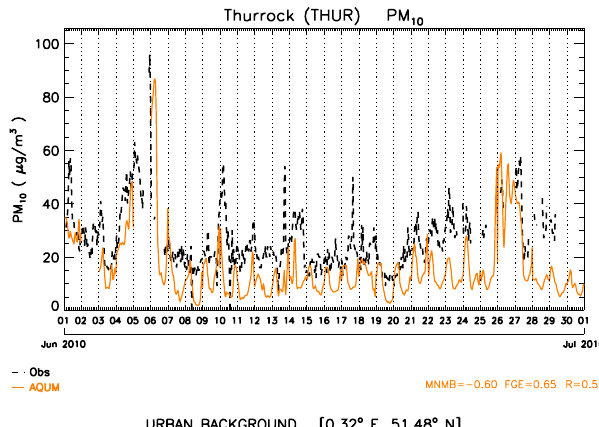
Fig. 7. Time series of hourly PM 10 concentrations (µgm − 3 ) for the urban background site at Thurrock, east of London, for June 2010. Observed concentrations are shown as the black dashed line and the model output as the solid orange line.